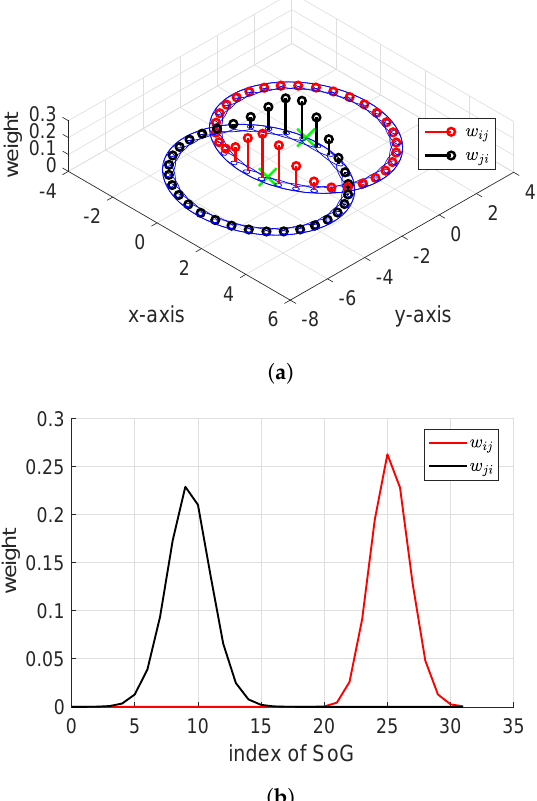
Figure 6. Weight symmetry between w k of the i th and j th nodes. ( a ) The SoG variables are distributed in the xy plane, and the weight is shown on the z-axis. ( b ) The weights w k